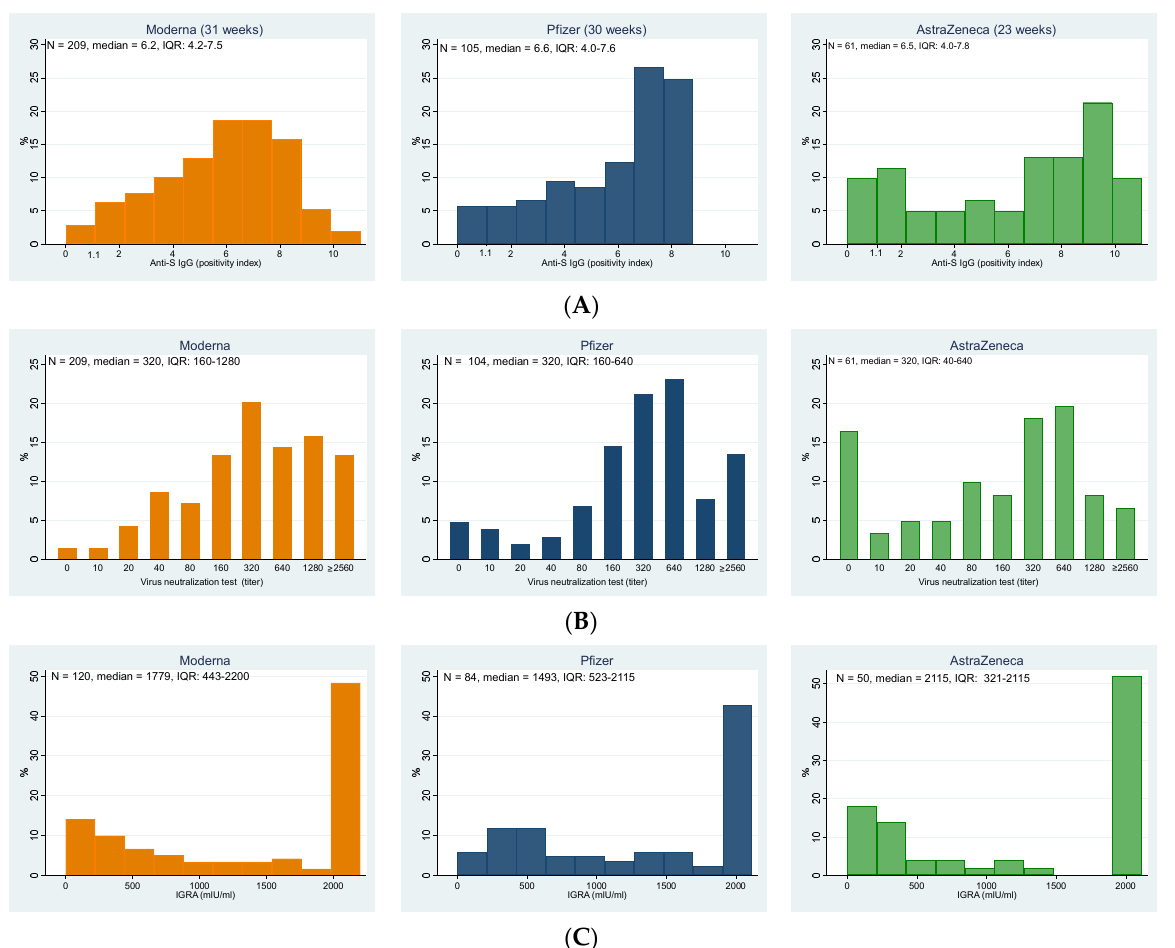
Figure 1. Distributions of the ( A ) levels of anti-S IgG, ( B ) titers of virus neutralization test against delta strain, and ( C ) results of interferon-gamma release assay indicating T-cell immunity for in- dividual vaccines; note that the vaccination-to-test period for AstraZeneca is shorter (23 weeks) than for the Moderna and Pfizer (31 and 30 weeks, respectively). ( A ) Anti-S IgG (positivity index) (values > 1.1 indicate the presence of antibodies in the sample); ( B ) Virus neutralization test against delta strain (titer); ( C ) IGRA